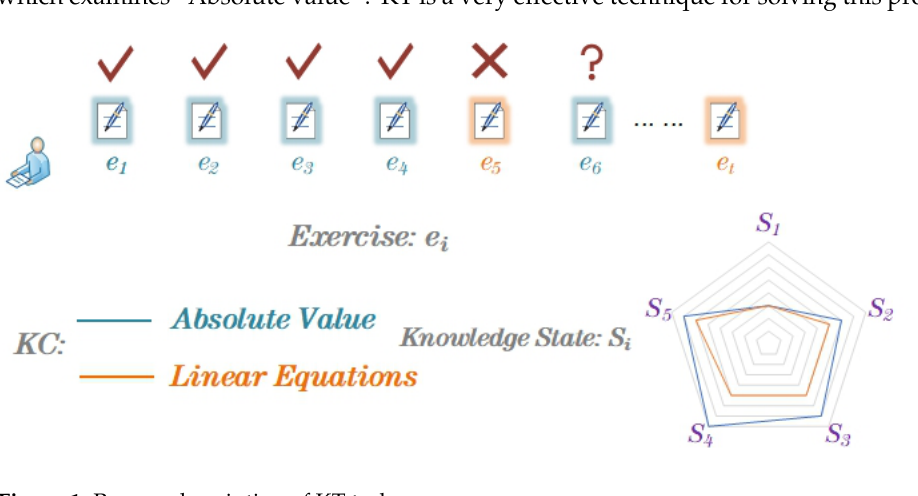
Figure 1. Process description of KT